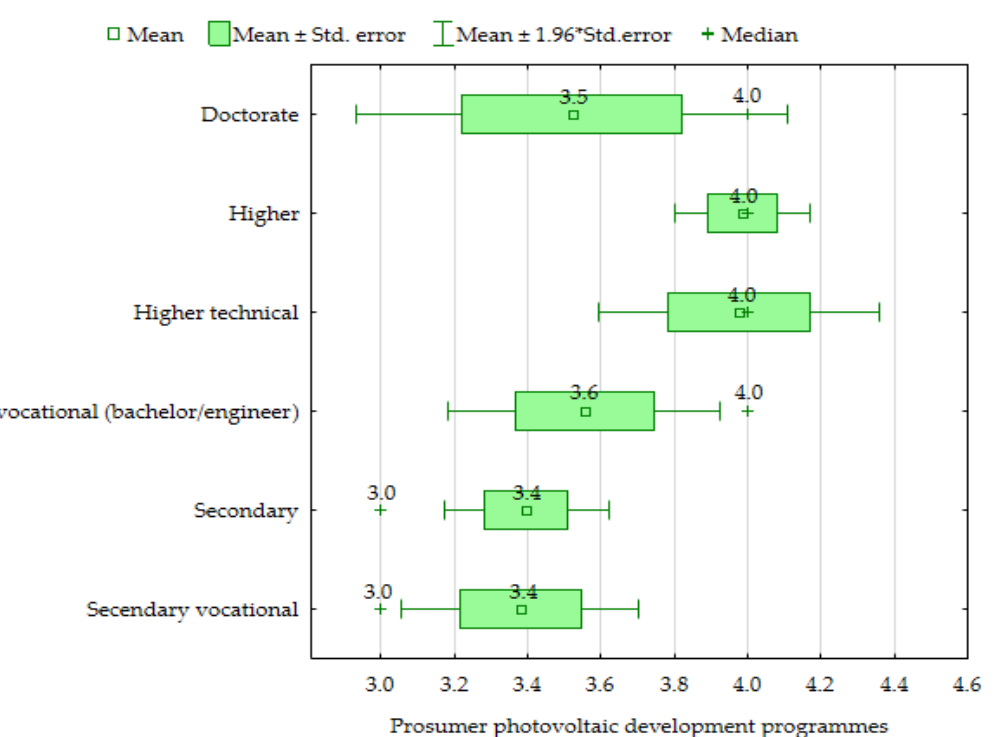
Figure 9. Impact of education on the evaluation of prosumer photovoltaic development programmes in decarbonization. Source: Own elaboration based on the conducted research, n = 444.